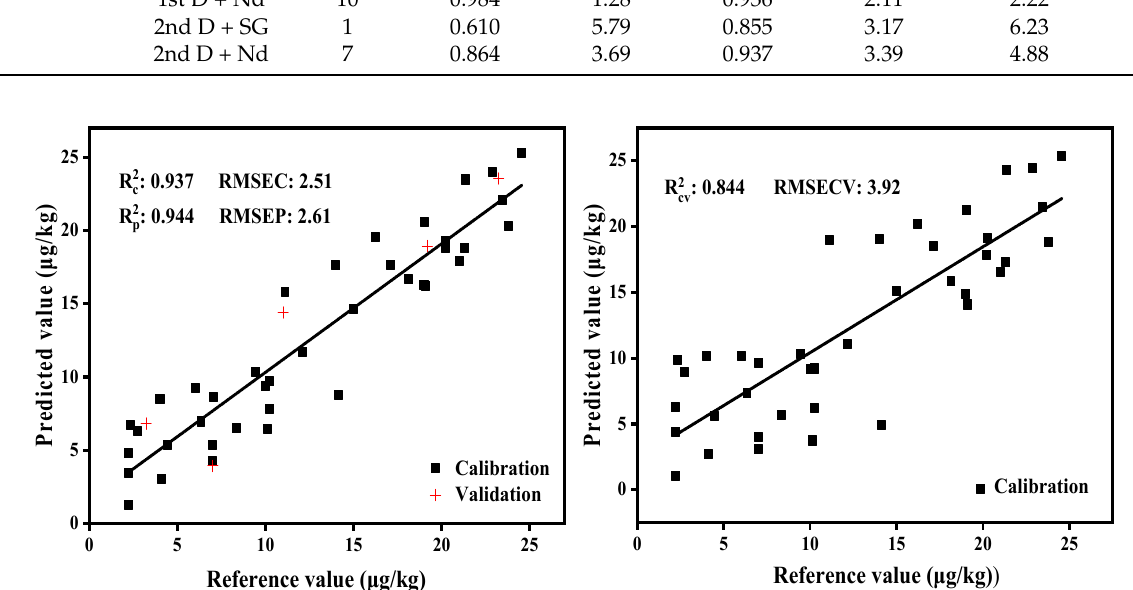
Table 3. Descriptive statistics of the PLS models for the calibration and validation sets.